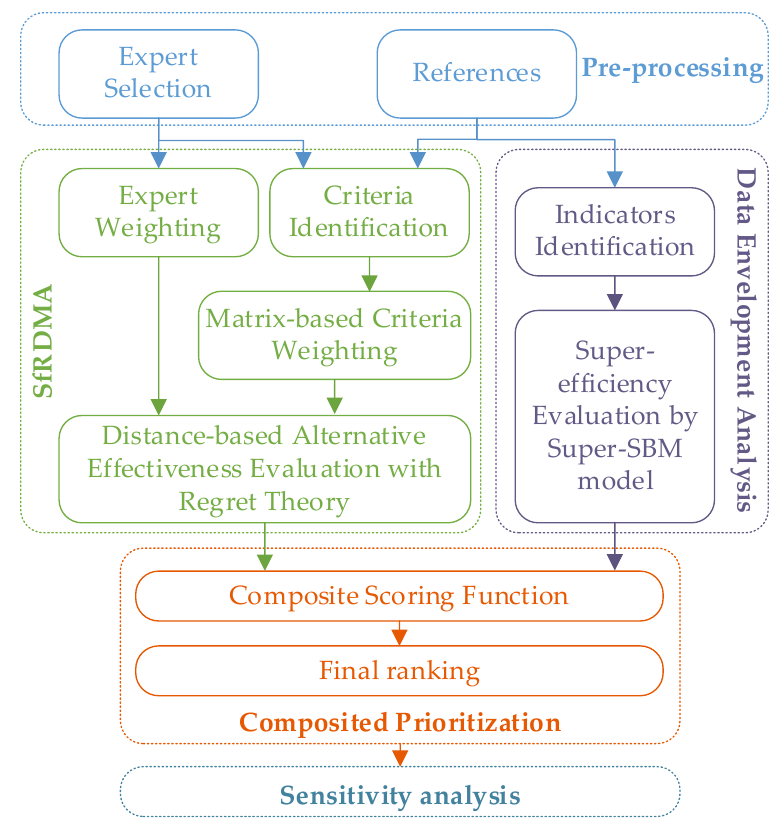
Figure 1. The proposed